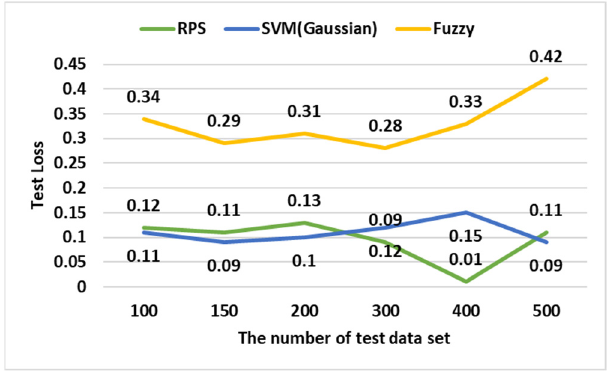
Figure 15. The accuracy according to the test data.